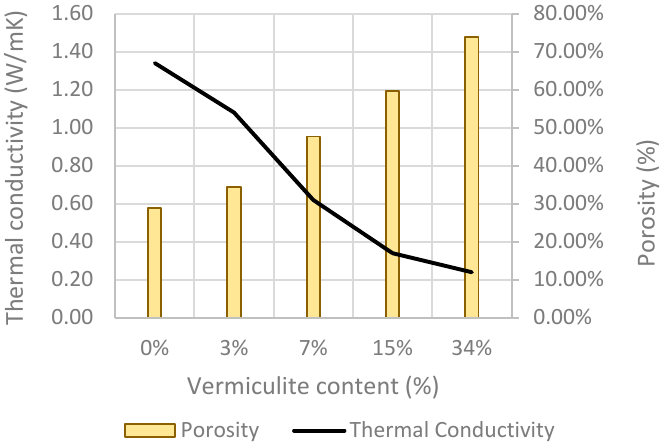
Figure 15. Relationship between thermal conductivity and porosity results from the study by Koksal et al. (2015) [48].